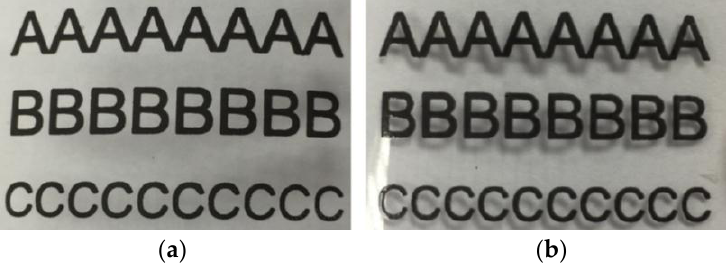
Figure 12. Printed samples of black UV-curable screen printing inks from HDAN-900 ( a ); EB524 ( b ).